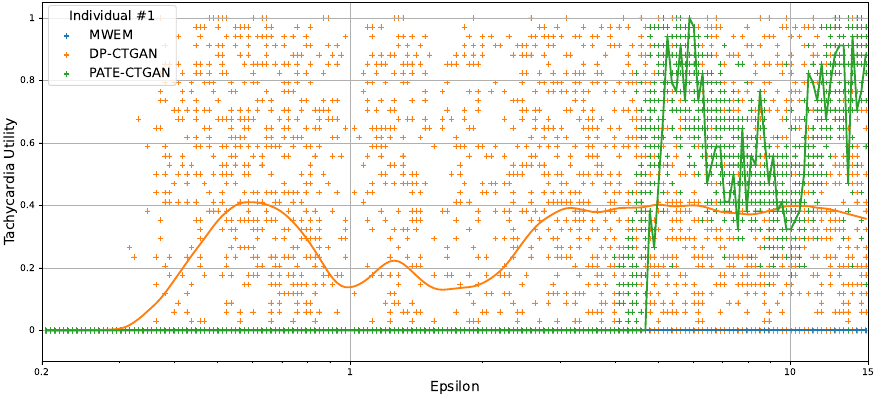
Figure 5. Scatter plot illustrating the continuous evaluation of the Tachycardia Utility (TU) for an individual using MWEM, DP-CTGAN,! and PATE-CTGAN at 20 runs. Overall, the TU for MWEM is out of competition for all individuals. It remains at 0 for any (cid:101) and shows no improvement for larger (cid:101) values. This is indicated by the first black line above the values of DP-CTGAN in orange. In addition, the observation can be